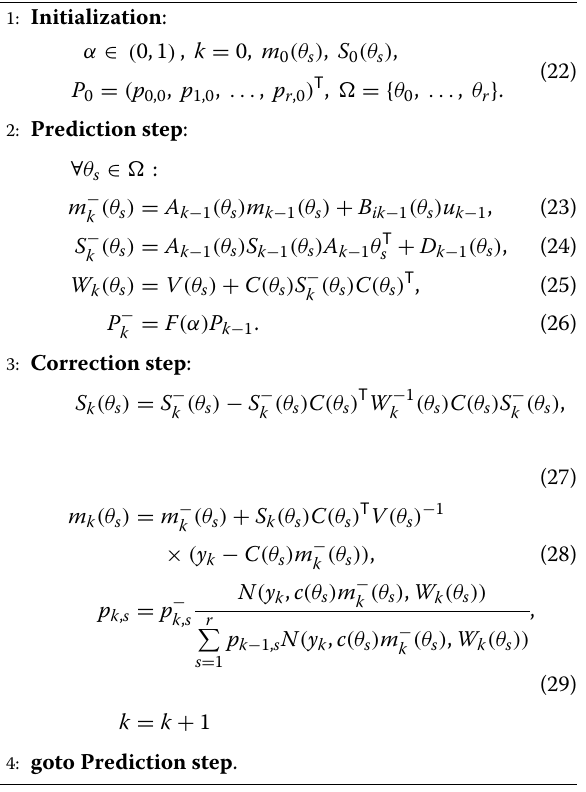
Algorithm 1 Fault detecting Field Kalman